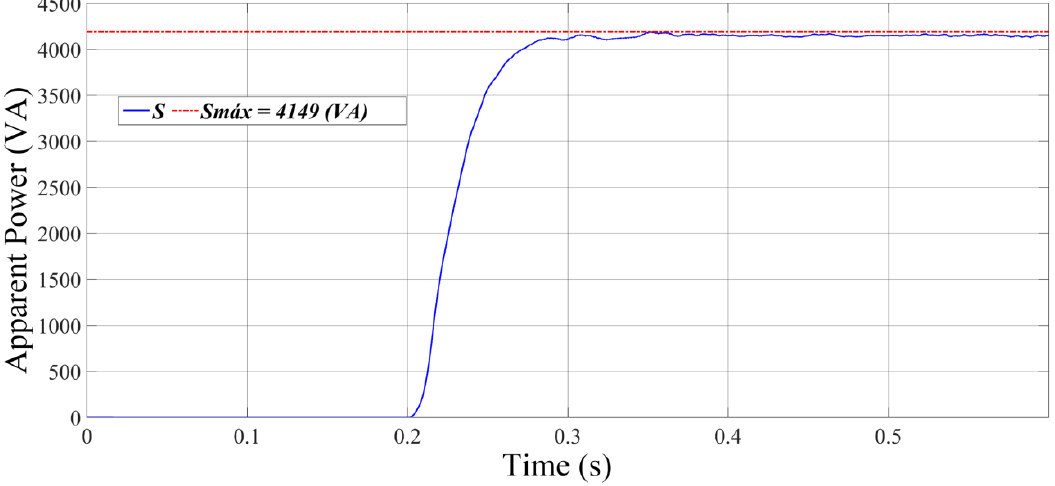
Figure 12. Fractional apparent power (S) supplied by the inverter, 500 VA/div. Horizontal axis: 100 ms/div.